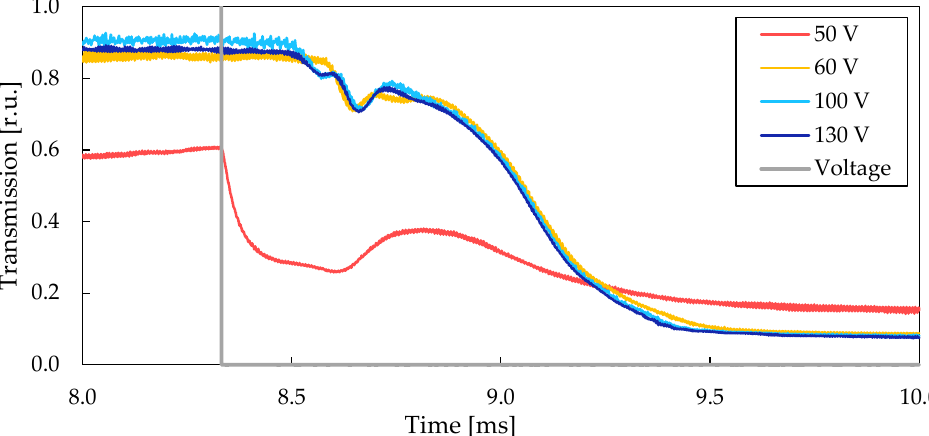
Figure 16. Electro-optical response of diffuser, depending on electric field. Once above switching threshold, nature of the curve does not change depending on voltage.